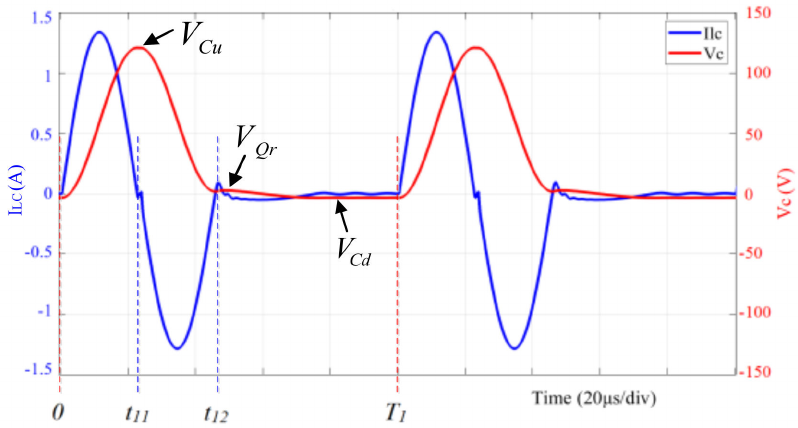
Figure 5. The waveform of capacitor voltage and quasi-resonant current.